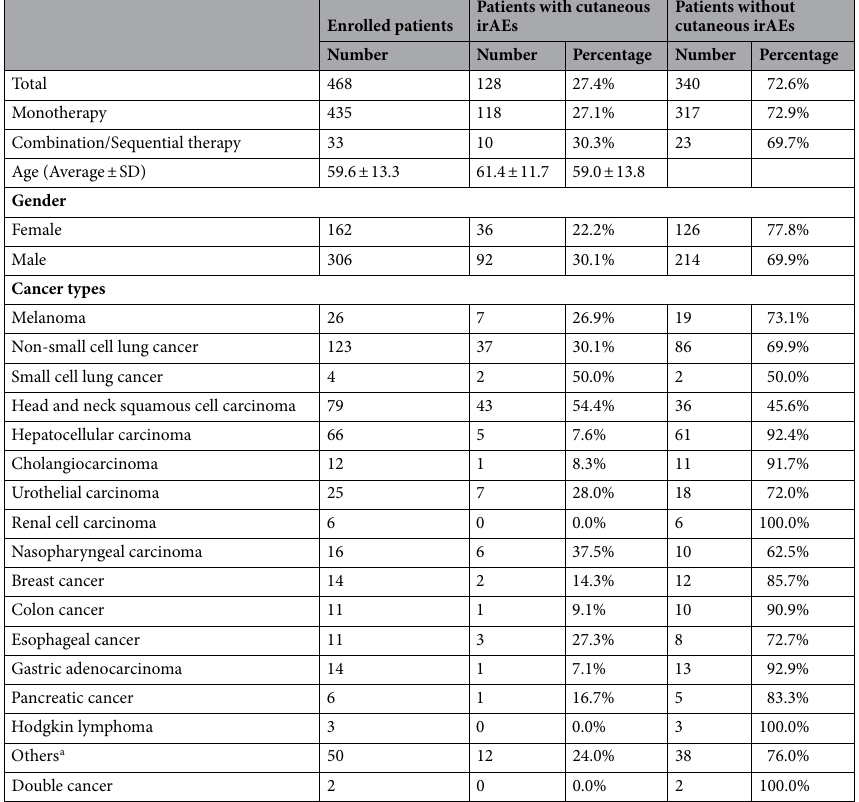
Table 1. Demographics and incidence of cutaneous irAEs. Diffuse intrinsic pontine glioma, metastatic cancer, precursor T-cell lymphoblastic lymphoma, anaplastic oligodendroglioma, endometrioid adenocarcinoma, glioblastoma, epithelioid sarcoma, acute myeloid leukemia, salivary adenocarcinoma, osteosarcoma, ear adenoid cystic carcinoma, Merkel cell carcinoma, parotid adenocarcinoma, uterine sarcoma, ovarian